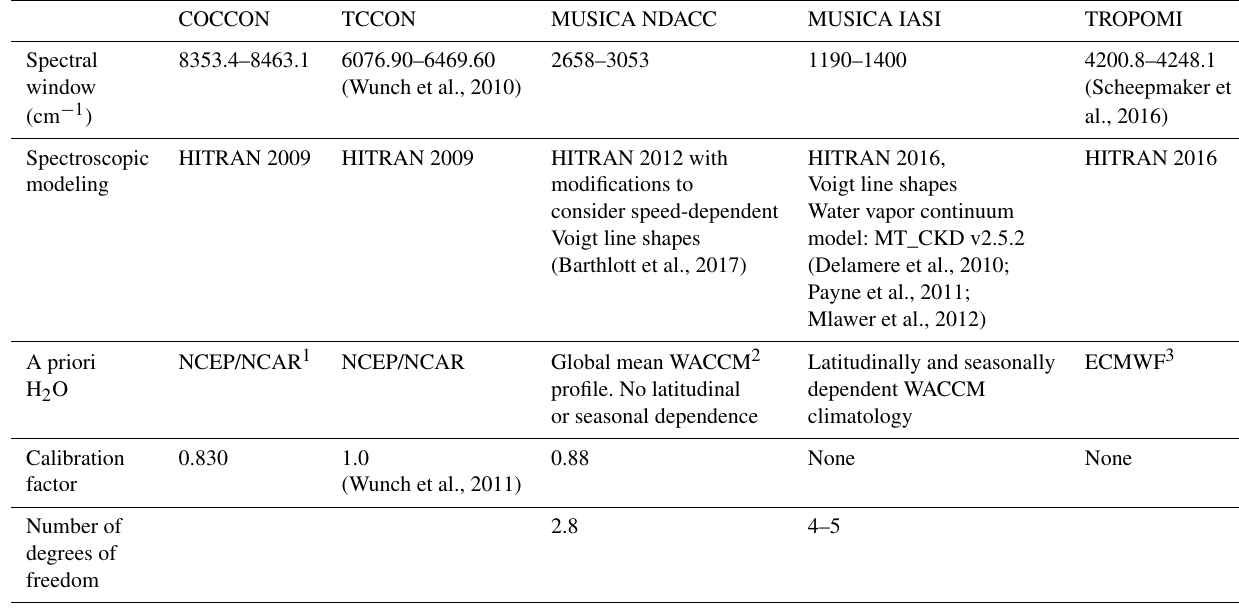
Table A1. Parameters of different instruments used in this